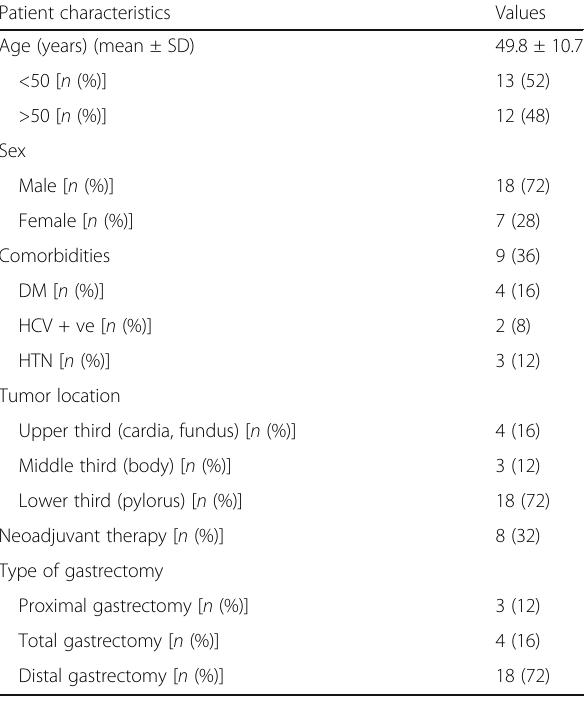
Table 1 Patient characteristics ( n = 25) Patient characteristics